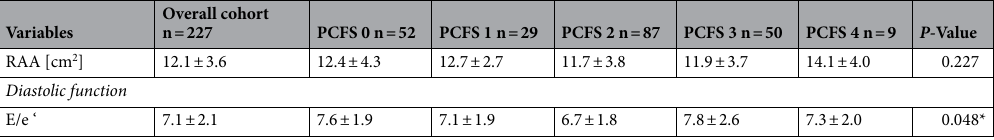
patient had more than two vaccinations. There were no statistical differences between vaccination and any of the parameters assessed. The antibody titer after COVID-19 are shown in Tables 1 and 2. The most frequently self-reported symptoms were fatigue (70%) and dyspnea (56%) (Fig. 1). Higher scores in PHQ-9 (depression), GAD-7 (anxiety), and PHQ-15 (somatic symptoms) correlated with functional limitation / PCFS and fatigue / MFI-20 ( P < 0.001). Cardiac characteristics and post‑COVID‑functional‑scale (PCFS). Patients with higher PCFS scores were more likely to report a severe clinical course of COVID-19 ( P < 0.001). The functional impairment in PCFS did not correlate with cardiac comorbidities except for diabetes mellitus type 2 and obesity (Table 1). More comorbidities were predictive for higher functional impairment according to PCFS ( P < 0.013). Patients in the PCFS groups 0 to 3 exhibited laboratory parameters within normal range (Fig. 1). Only 4% of the study PCFS 4 had more often diabetes mellitus ( P < 0.001). Echocardiography showed no relevant differences for LVEF, TAPSE, LVEDV, LVESV, LAVI, RVEDD, RAA,